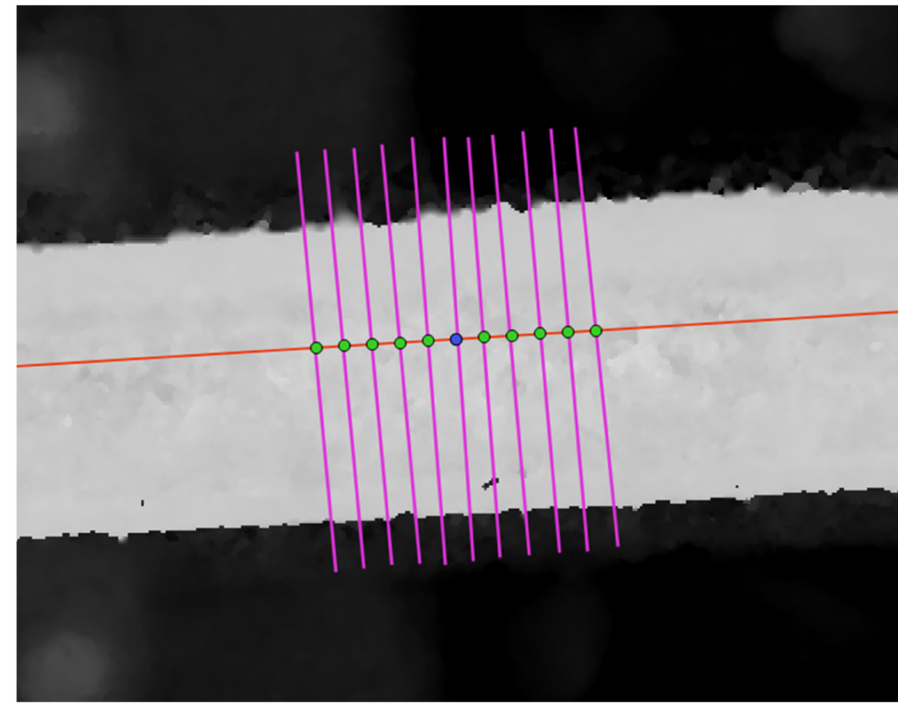
Figure 9. Multiple profiles on both sides of the considered profile, 5 cm on either